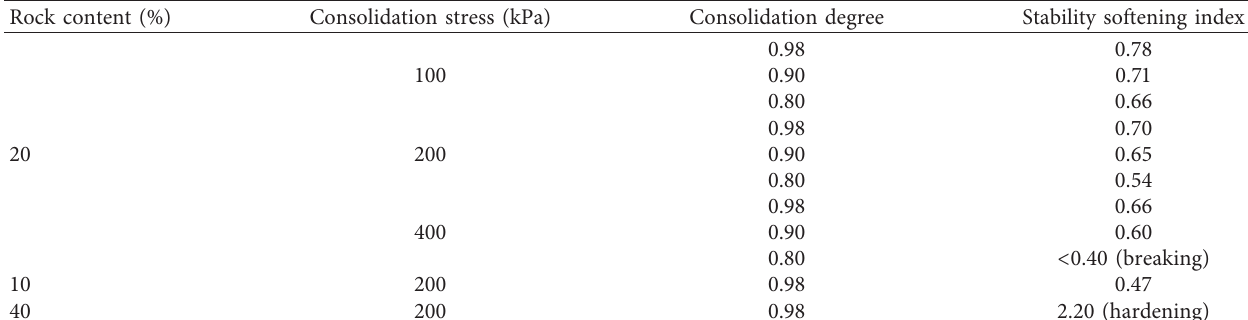
Table 3: Impact of various factors on the softening index.